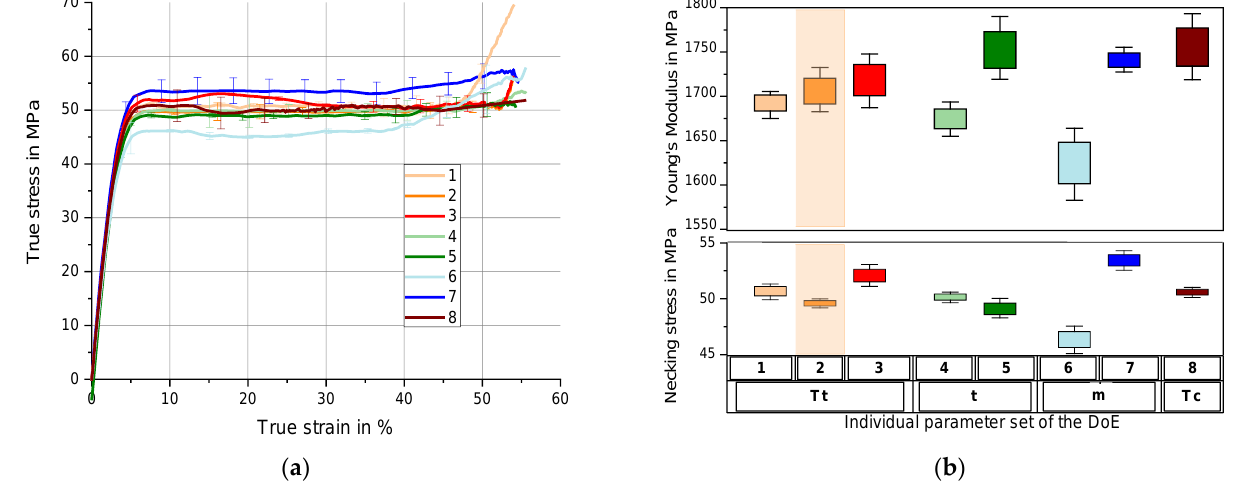
Figure 2. Uniaxial Tension Tests; ( a ) true stress–strain-behaviour dependent on different process parameters; ( b ) Young’s Modulus and necking stress dependent on process parameters (reference in orange).